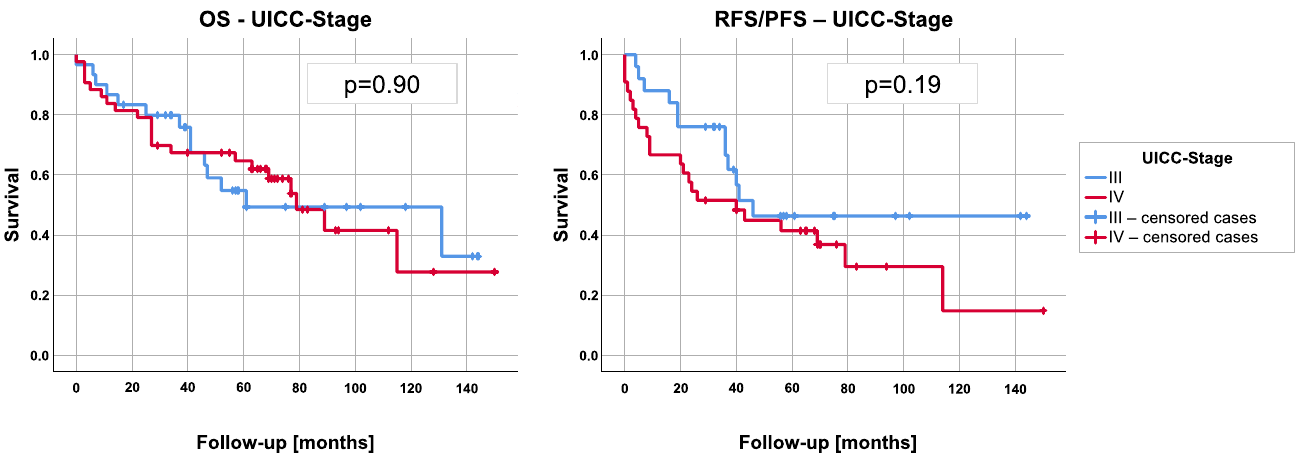
Figure 2. Overall survival (OS) and recurrence/progression-free survival (RFS/PFS) depending on UICC classification.